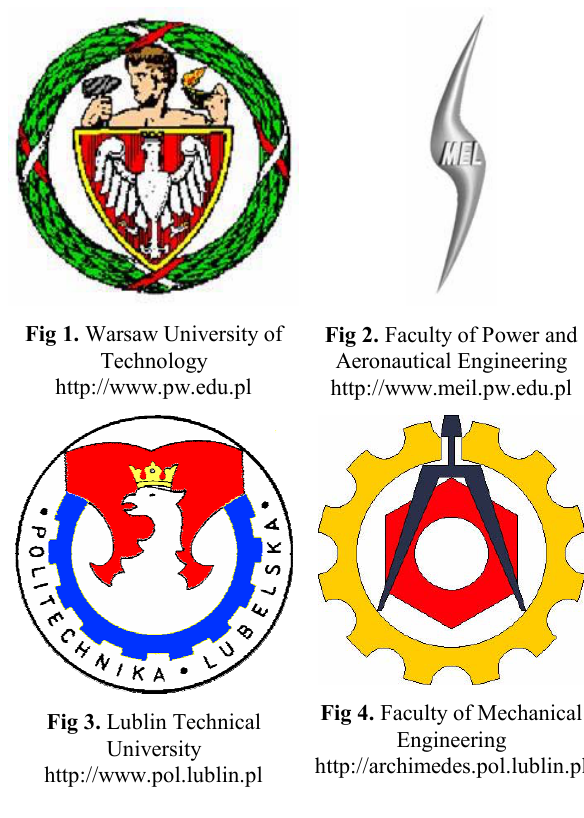
Fig 3. Lublin Technical Fig 4. Faculty of Mechanical